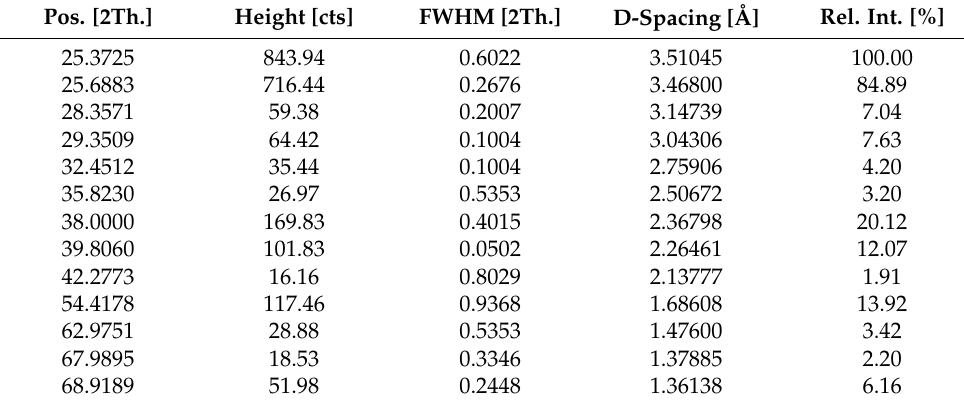
Figure 6. XRD pattern of the anatase sample (intensity in arbitrary units vs. diffraction angle 2 θ ), with representative d-spacings (Å) and corresponding lattice planes (Miller indexes in brackets). Table 1. Complete XRD experimental data.